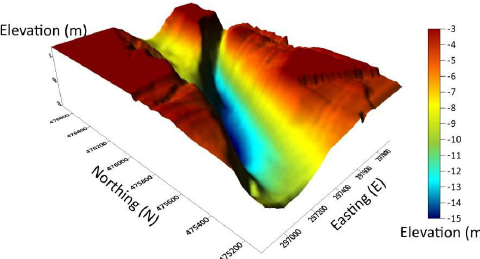
Figure 17. A 3D bathymetric plan relative to the on-site